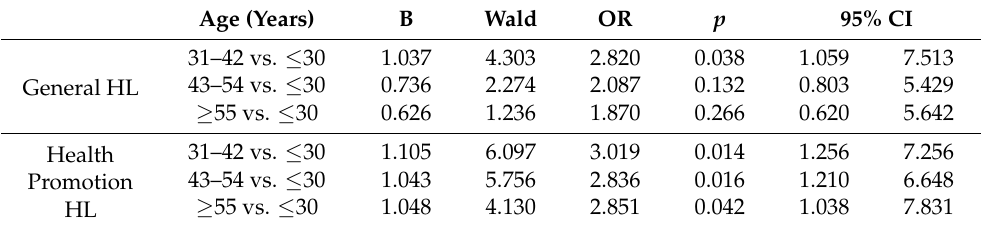
Table 3. Binary logistic regression analysis in Health promotion HL ( N =